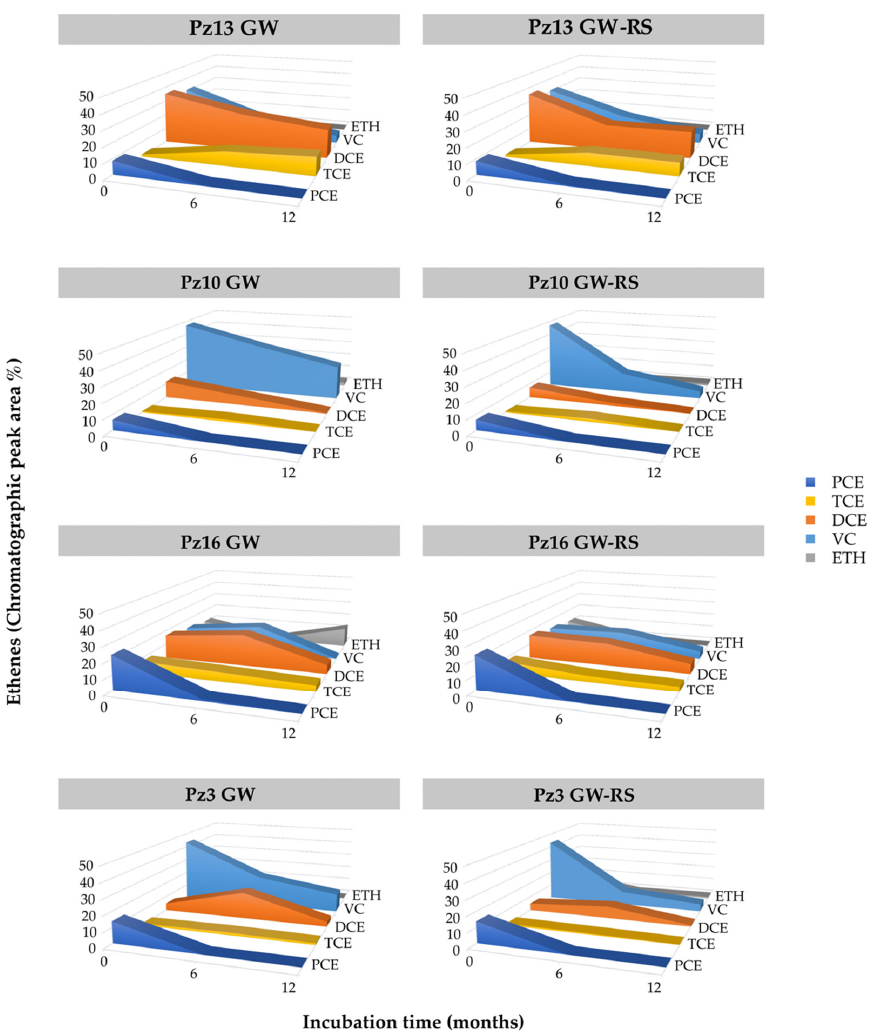
Figure 3. Relative abundance of CE in the microcosms with groundwater sampled from Pz13, Pz10, Pz16 and Pz3 incubated for 6 and 12 months without and with reducing substrate (GW and GW-RS, respectively).